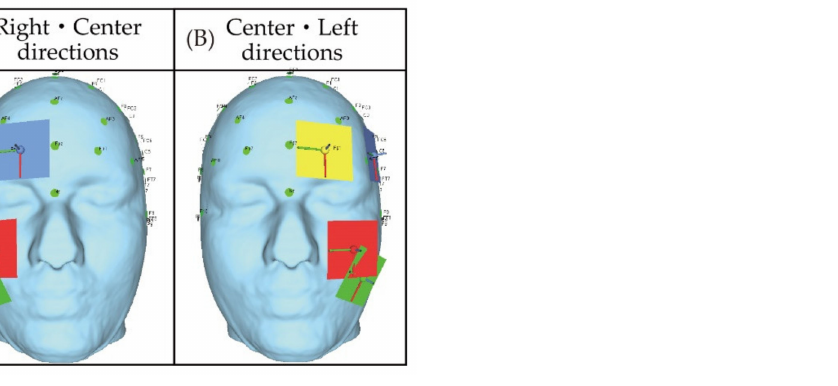
Figure 10. The electrode placement that stimulates only the right eyeball and the electrode placement that stimulates only the left eyeball.